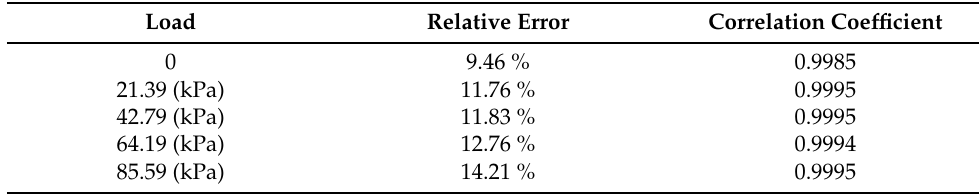
Table 5. Relative error and correlation coefficient for